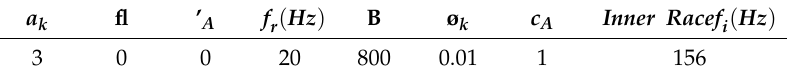
Table 1. The parameters selection with simulation signal of bearing inner race.